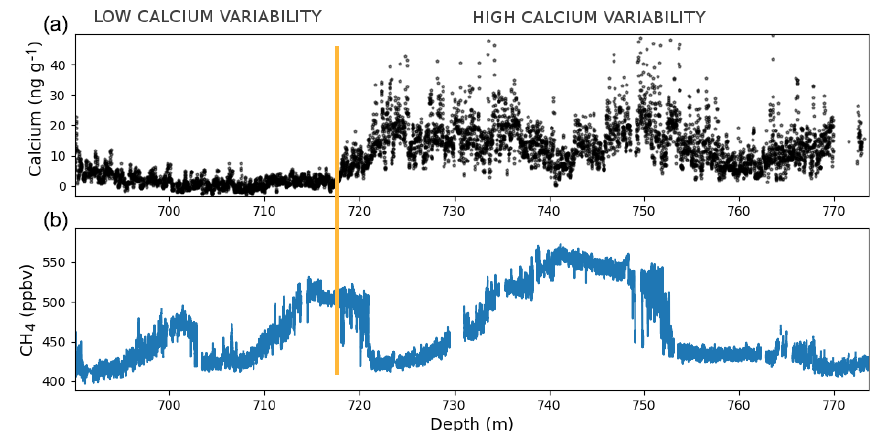
Figure 6. (a) Calcium concentrations measured in the EPICA Dome C ice core section covering the DO events 6 to 9 (Lambert et al., 2012). (b) Methane mixing ratios measured in this